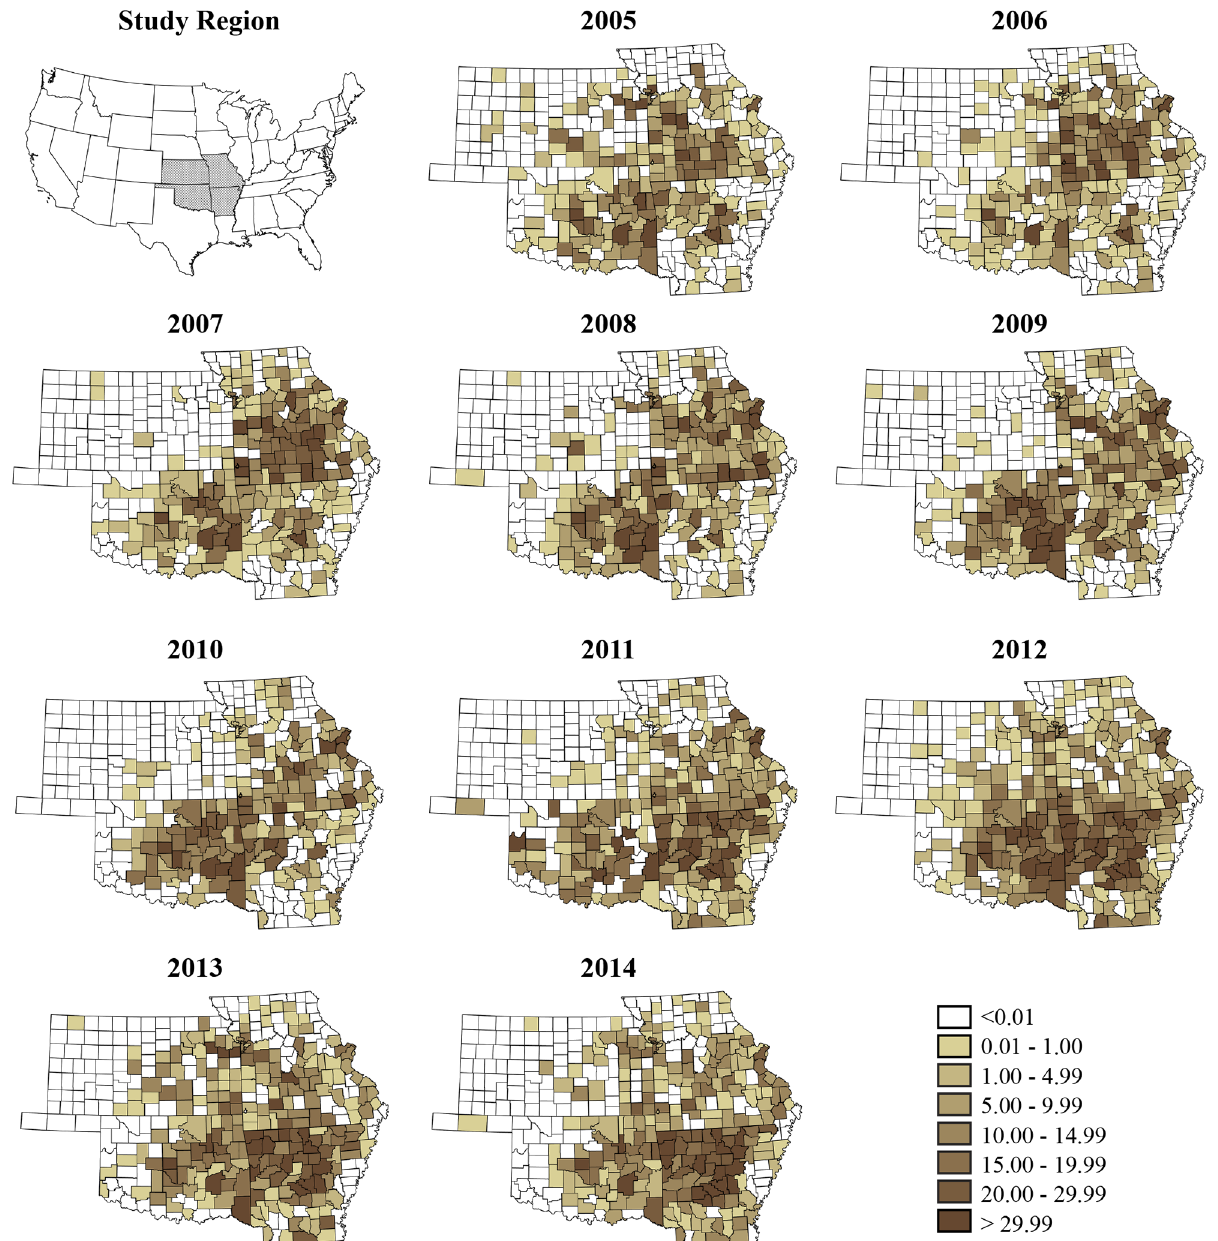
Fig 3. County – level crude rate estimates of Rocky Mountain spotted fever prevalence reported to the state health departments for the study period, 2005 –